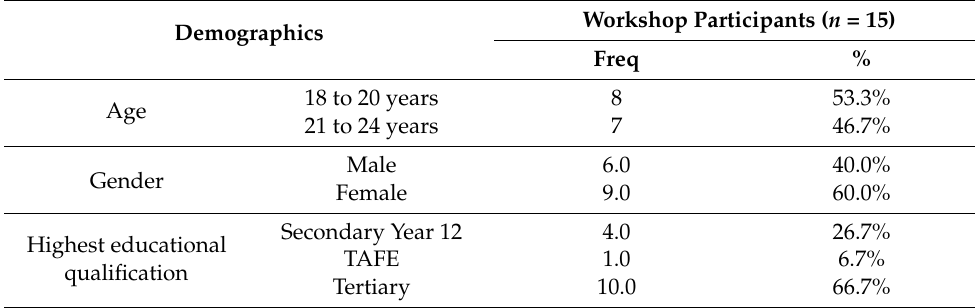
Table 2. Characteristics of workshop